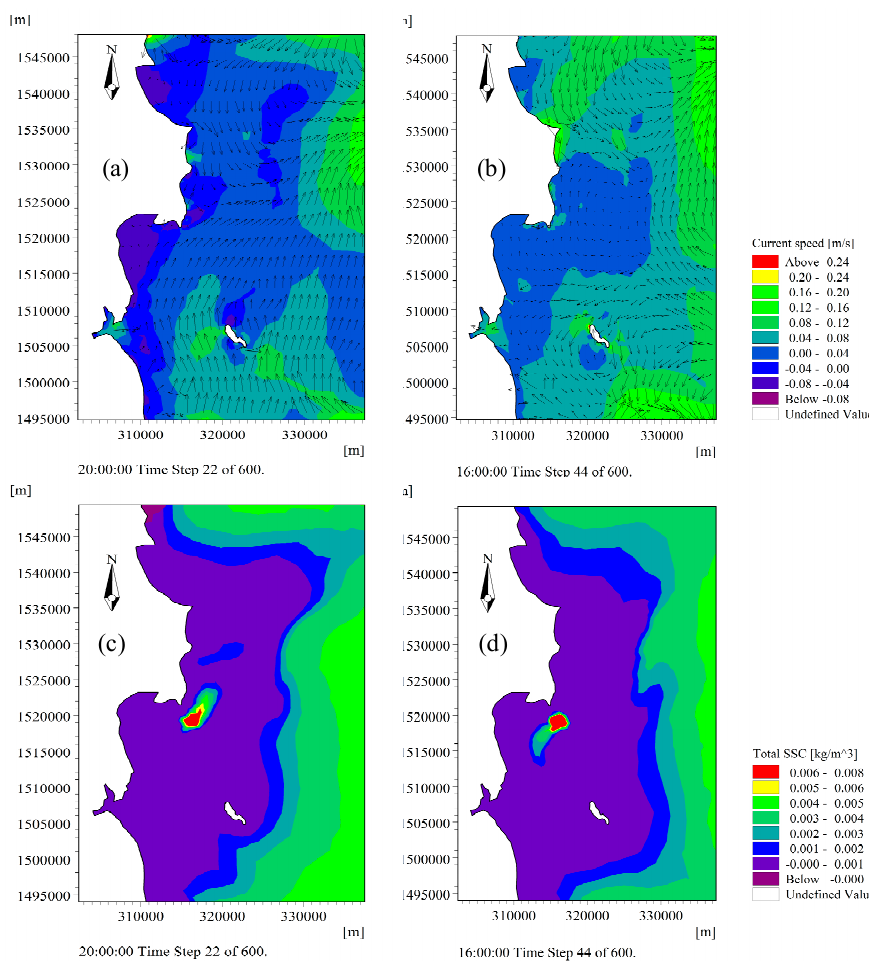
Figure 9. The simulation results of S2. Streamflow field during ( a ) low tide; ( b ) high tide. Distribution of suspended sediment concentration (SSC) during ( c ) low tide; ( d ) high tide.